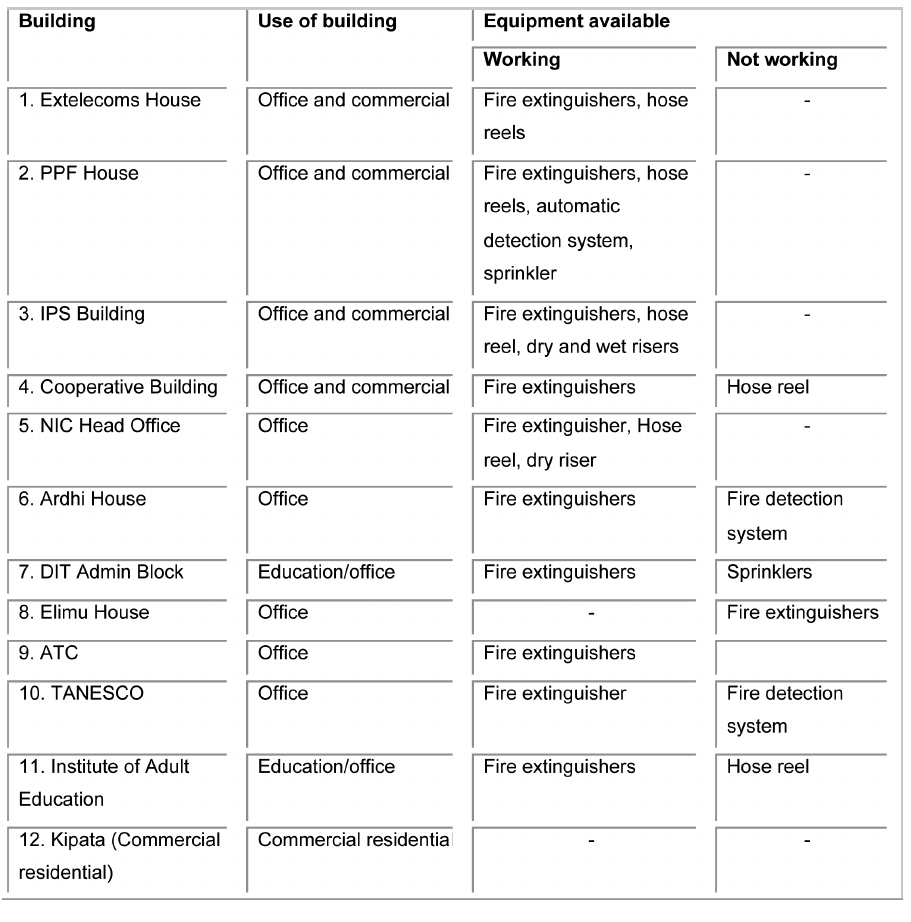
Table 2. Means, equipment and their condition